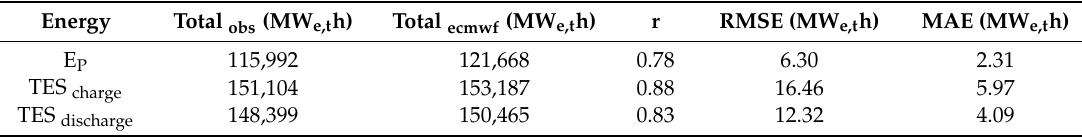
Table 1. Statistical and descriptive analyses for the hourly values of electric energies into the grid, E P (MW e h), and stored thermal energy, TES (MW t h), charge and discharge energies based on measurements (obs) and forecasts (ecmwf). The sum of the hourly values (Total) of E P and TES corresponded to one year of data (from 1st July 2017 to 30th June 2018), produced by a central receiver power plant with configuration similar to the Gemasolar thermal power plant (Sevilla province, Spain), simulated through the System Advisor Model (SAM). Hourly statistical error metrics for the correlation coefficient (r), root mean square error (RMSE), and mean absolute error (MAE) are